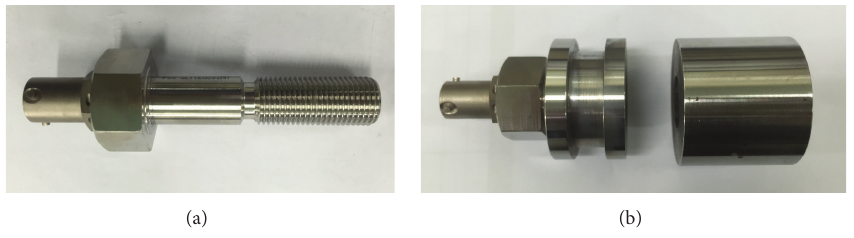
Figure 1: Ridge-cut explosive bolts (a) before separation and (b) after separation.